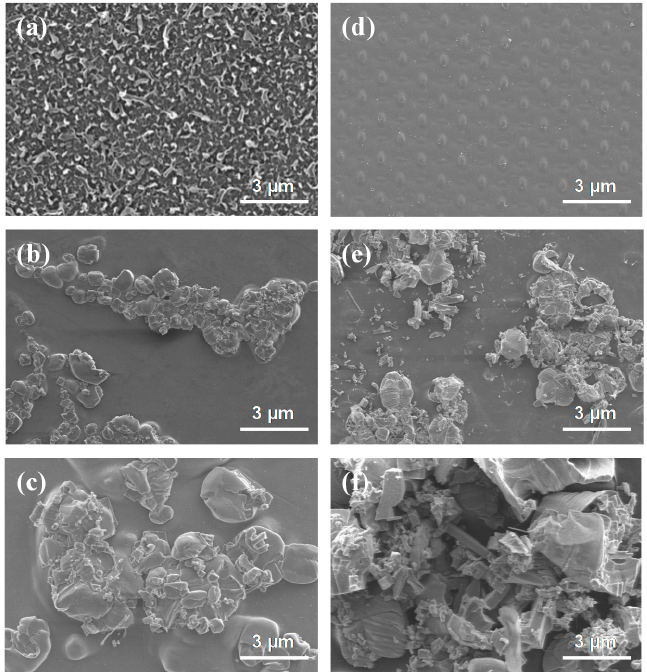
Figure 9. SEM images of the ( a ) active layer of pristine membrane, ( d ) support layer of pristine membrane, ( b , c ) active layer of fouled membrane, and ( e , f ) support layer of the fouled membrane. The fouled membrane was produced after 24 h experiment. FO process (in AL-FS mode); Flow rate: 300 mL/min; Temperature: 36.5 ± 0.5 °C.